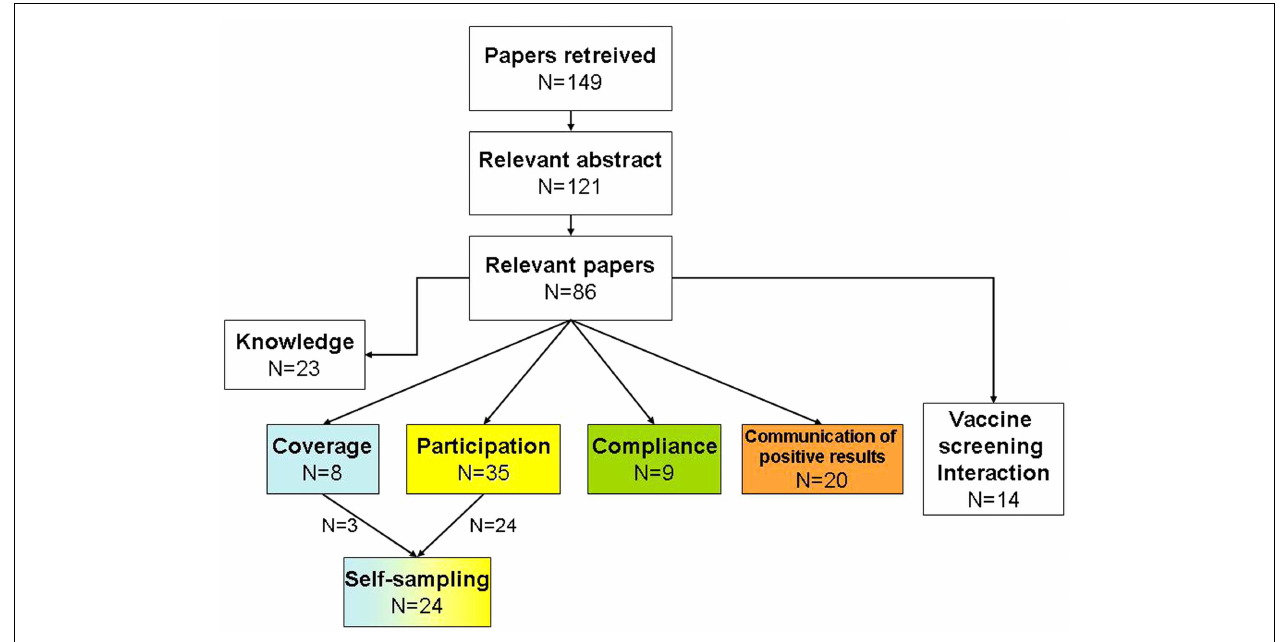
FIGURE 2 | Flowchart of the systematic search .The color code of the main topics is the same as reported in Figure 1 .